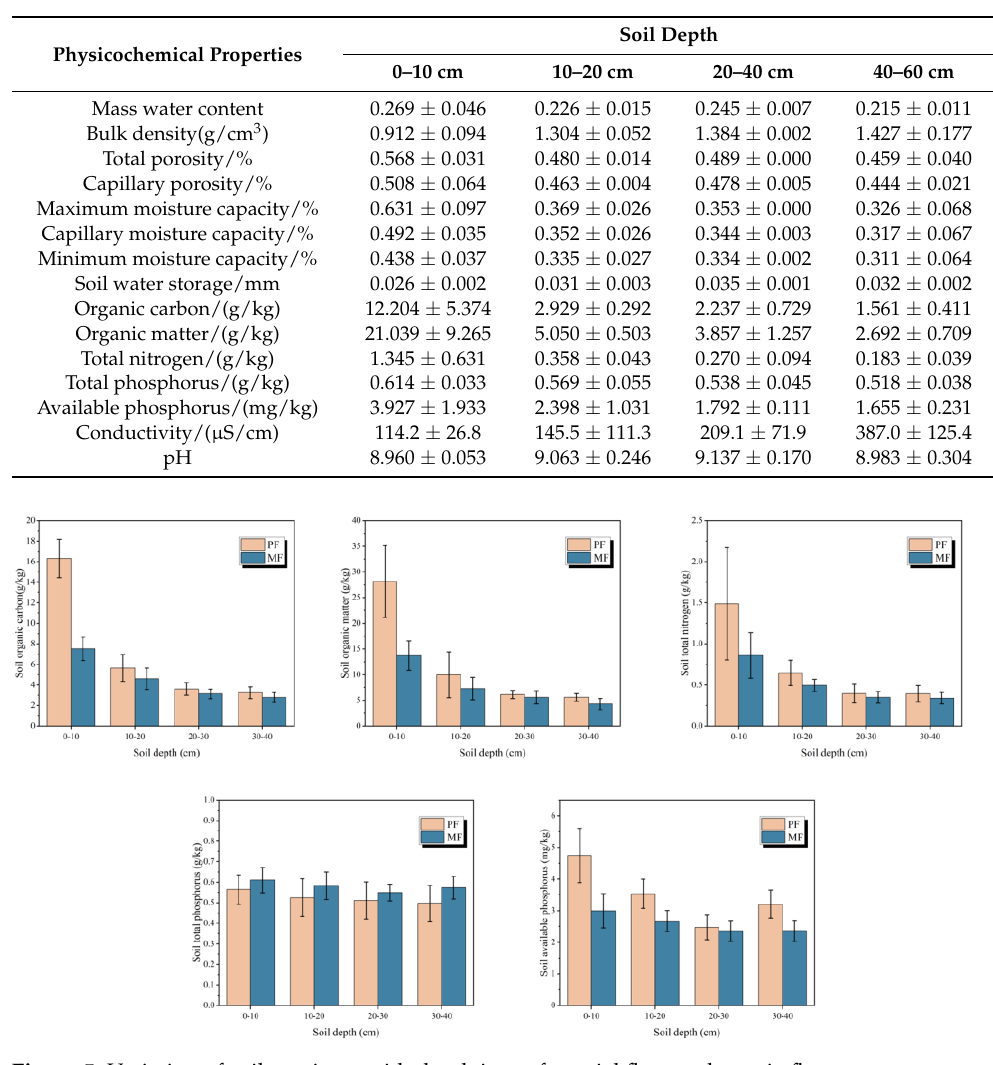
Figure 4. Changes of soil nutrients properties (( a ) means soil organic carbon, soil organic matter, ( b ) means total soil nitrogen, total soil phosphorus, ( c ) means soil available phosphorus) with soil depth.